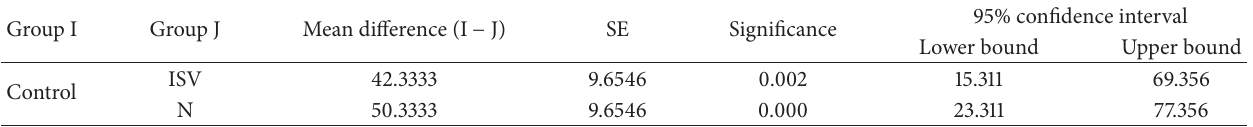
Table 6: Tukey’s HSD test analysis of colony forming units.